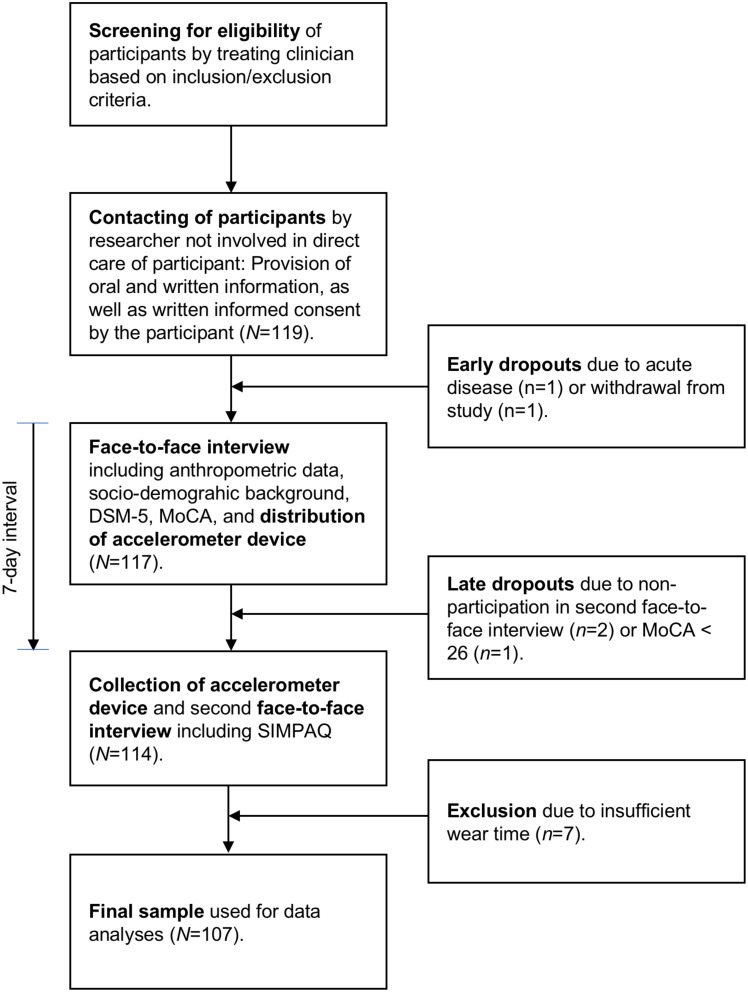
Graphical overview of study design, data assessment and participant flow chart.